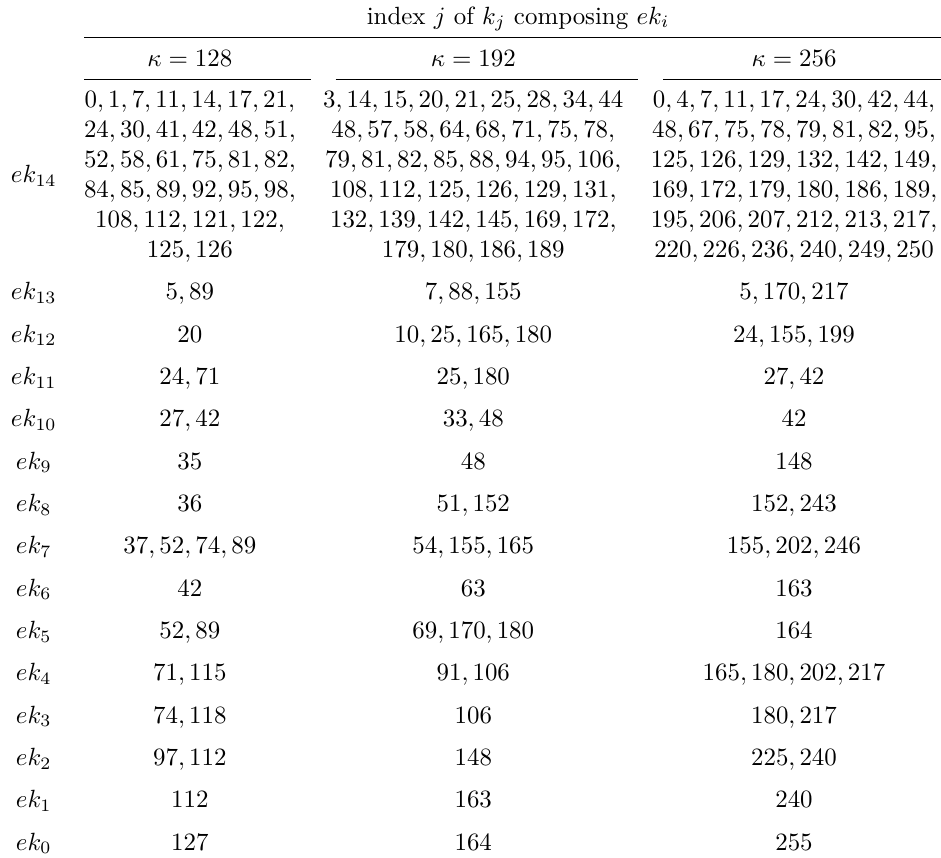
Table 7: Equivalent key c K = ( ek 14 , ek 13 , . . . , ek 0 ) for 384-round hull.